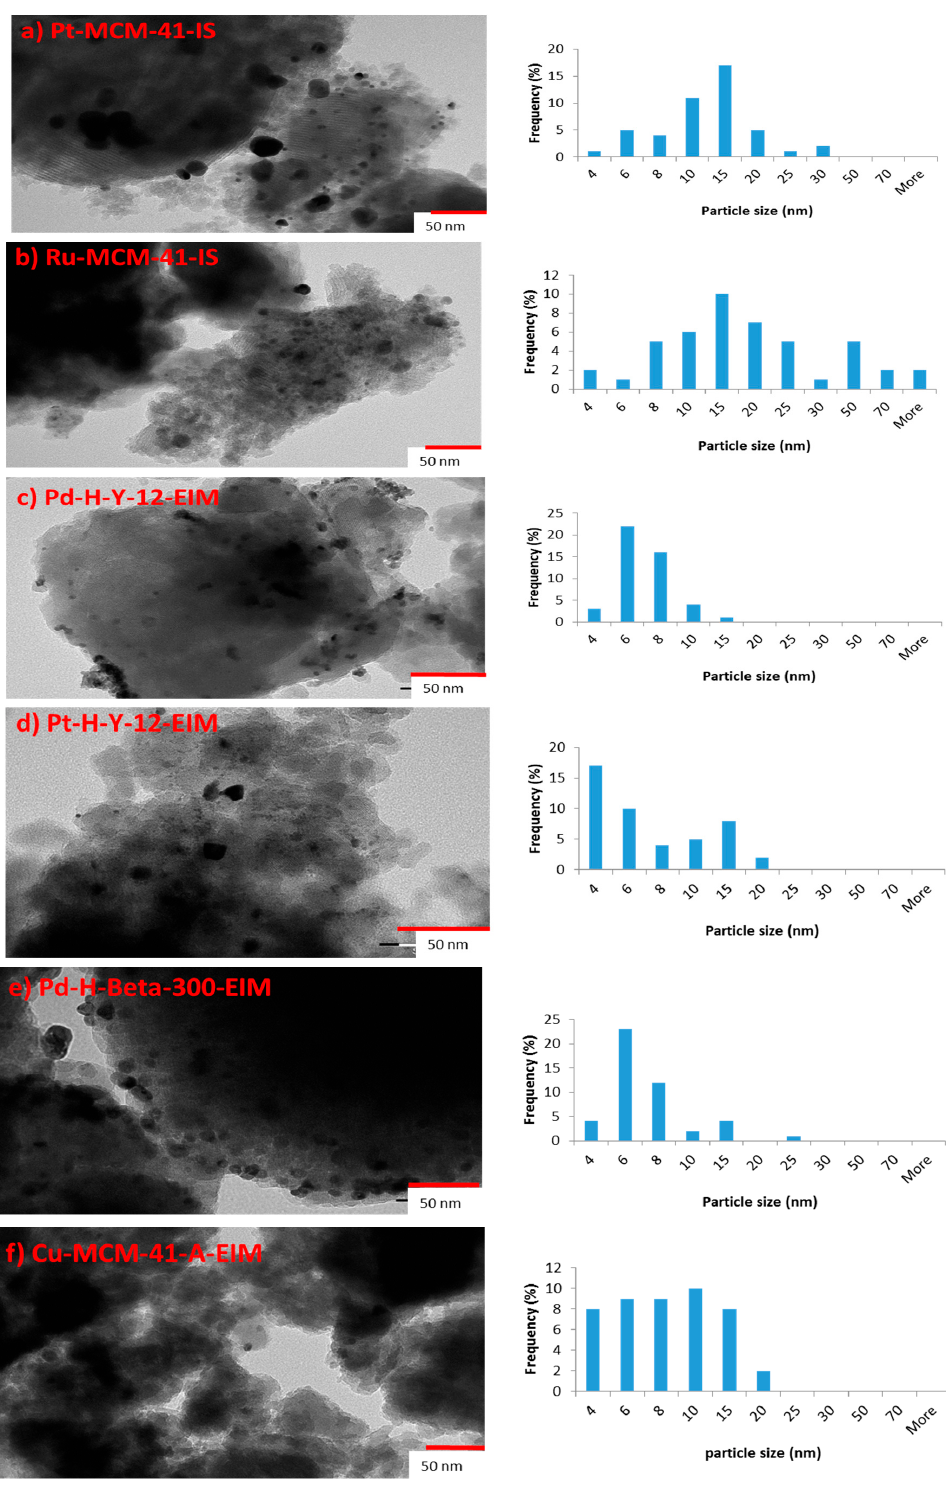
Figure 1. ( a ) TEM image and Pt particle size distribution histogram of Pt-MCM-41-IS, catalyst. ( b ) TEM image and Ru particle size distribution histogram of Ru-MCM-41-IS catalyst. ( c ) TEM image and Pd particle size distribution histogram of Pd-H-Y-12-EIM catalyst. ( d ) TEM image and Pt particle size distribution histogram of Pt-H-Y-12-EIM catalyst. ( e ) TEM image and Pd particle size distribution histogram of Pd-H-Beta-300-EIM catalyst. ( f ) TEM image and Cu particle size distribution histogram of Cu-MCM-41-A-EIM